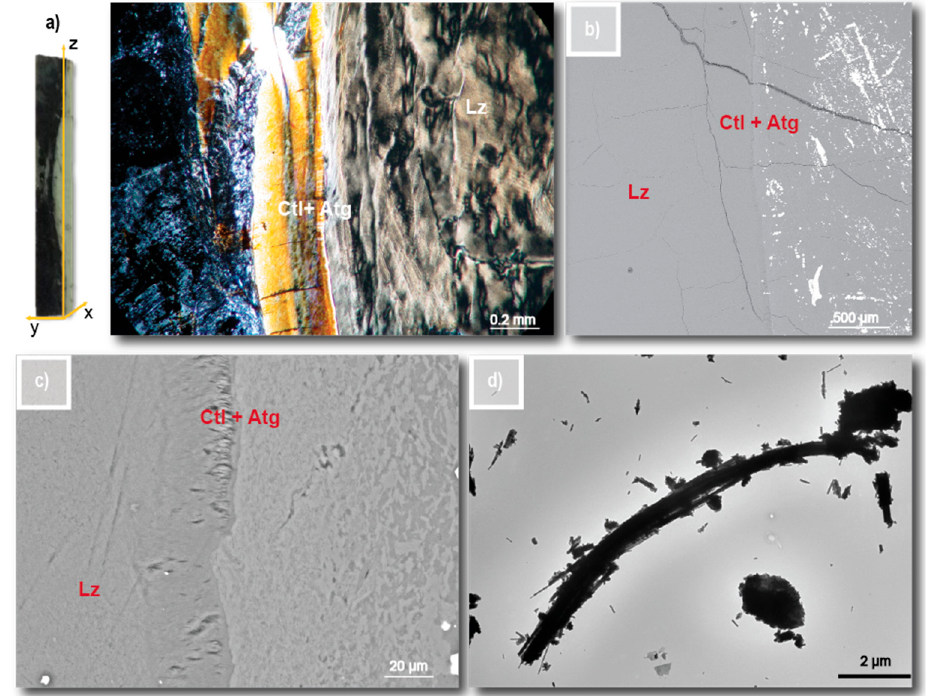
Figure 3. Sample 1 (S1). ( a ) Sample cut for tomographic scanning and photomicrography of the contact between the serpentinized peridotite and the lizardite vein; crossed polars. ( b ) SEM microphotograph (100× magnification) of serpentinized peridotite. ( c ) SEM microphotograph detail (2000× magnification) of the contact between the serpentinized peridotite and the lizardite vein (HV: 20 kV; Detector: Back-Scattered Electrons, BSE). ( d ) TEM image of a bundle of chrysotile fibers. Mineral name abbreviations are according to [36]. Atg: antigorite; Ctl: chrysotile; Lz: lizardite.